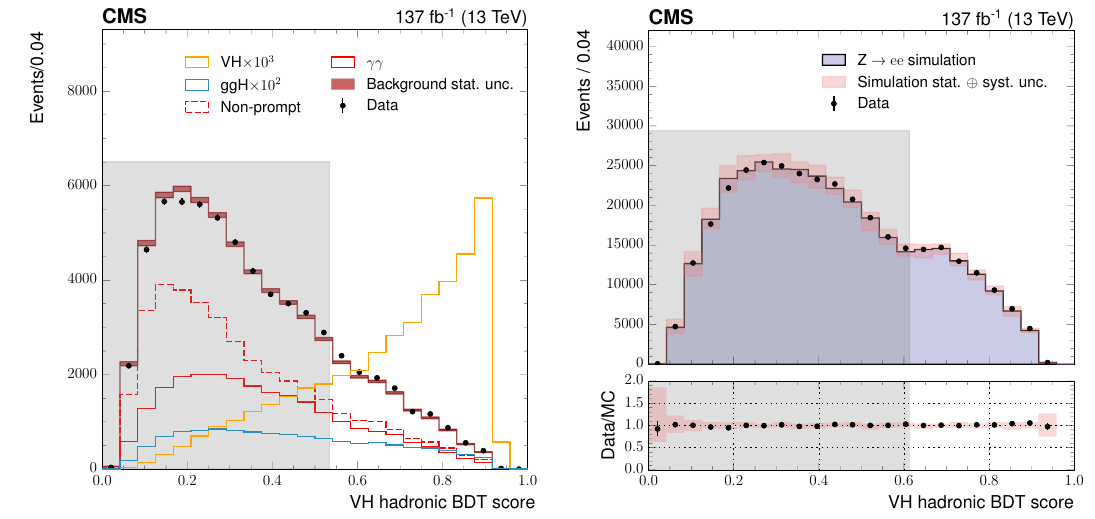
Figure 8 . The left plot shows the distribution of the VH hadronic BDT output score in events with m in the range 100–120 or 130–180 GeV, for data events passing the preselection (black gg points), and for simulated background events (red band). Histograms are also shown for different components of the simulated background in red. The sum of all background distributions is scaled to the data. The orange histogram corresponds to simulated VH hadronic signal events. The right plot shows the same distribution in Z → ee + jets events where the electrons are reconstructed as photons. The points show the score for data, the histogram shows the score for simulated Drell-Yan events, including statistical and systematic uncertainties (pink band). The regions shaded grey contain VH hadronic BDT scores below the lowest threshold used to define an analysis